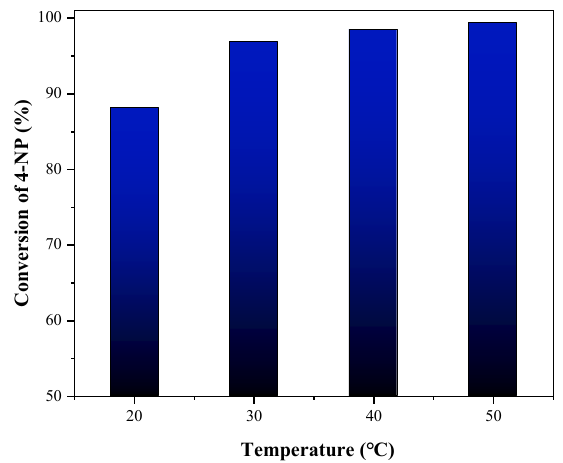
Figure 10. Effect of temperature on catalytic reaction of 1T-MoS 2 /PC.